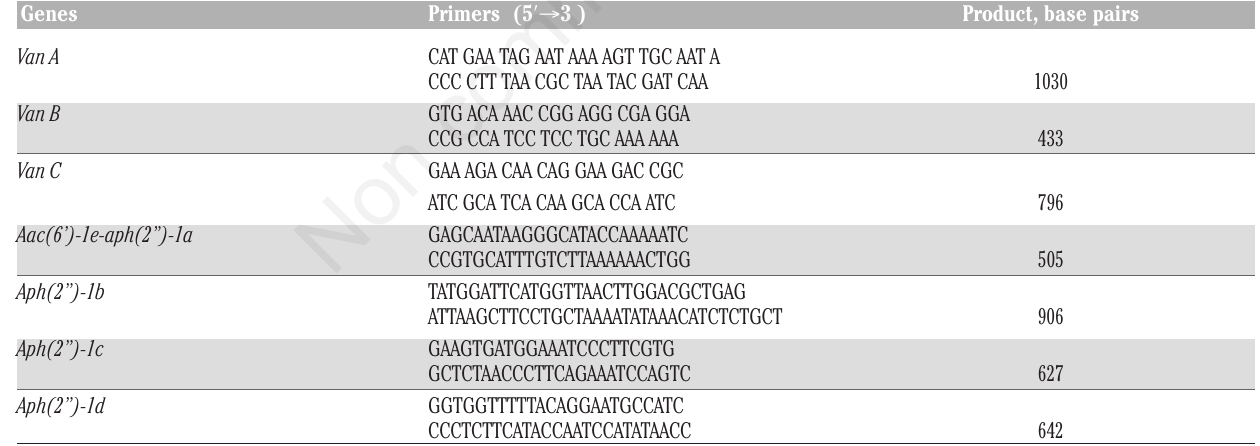
Table 1. Primer sequences used in polymerase chain reaction methods. Genes Primers (5 ′→ 3(cid:0))